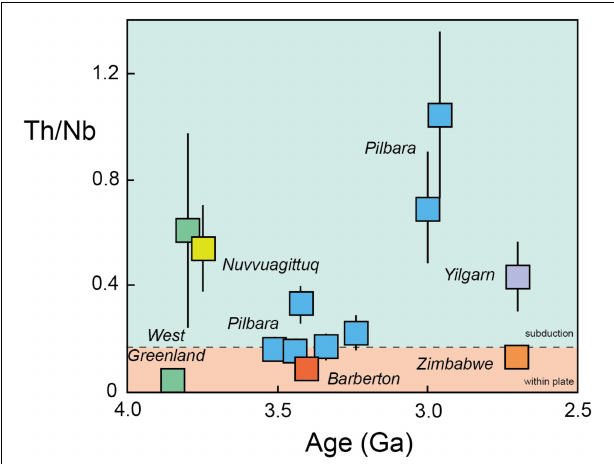
FIGURE 5 | Mean Th/Nb ratios of suites of Archean predominantly mafic rocks plotted against eruption ages, for suites which are thought not to have been modified significantly by crustal contamination. Green field is for elevated Th/Nb ratios, which are attributed to subduction-related processes, and the orange field is for within plate magmas. Data from: Barley et al. (1998), Smithies et al. (2004, 2005), Shimizu et al. (2005), O’Neil et al. (2007), Jenner et al. (2009, 2013), Puchtel et al. (2013), de Joux et al. (2014). The colors in the small squares reflect the different locations plotted (after Hawkesworth et al., 2019).